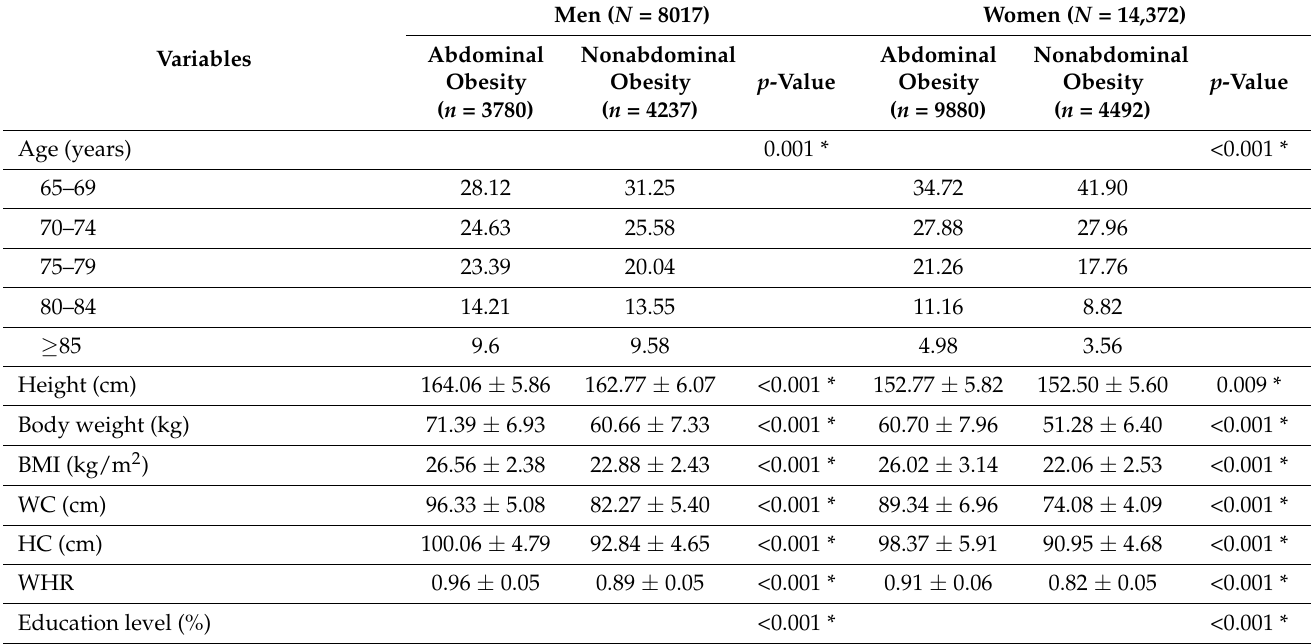
Table 1. Demographic characteristics and life habits of the study